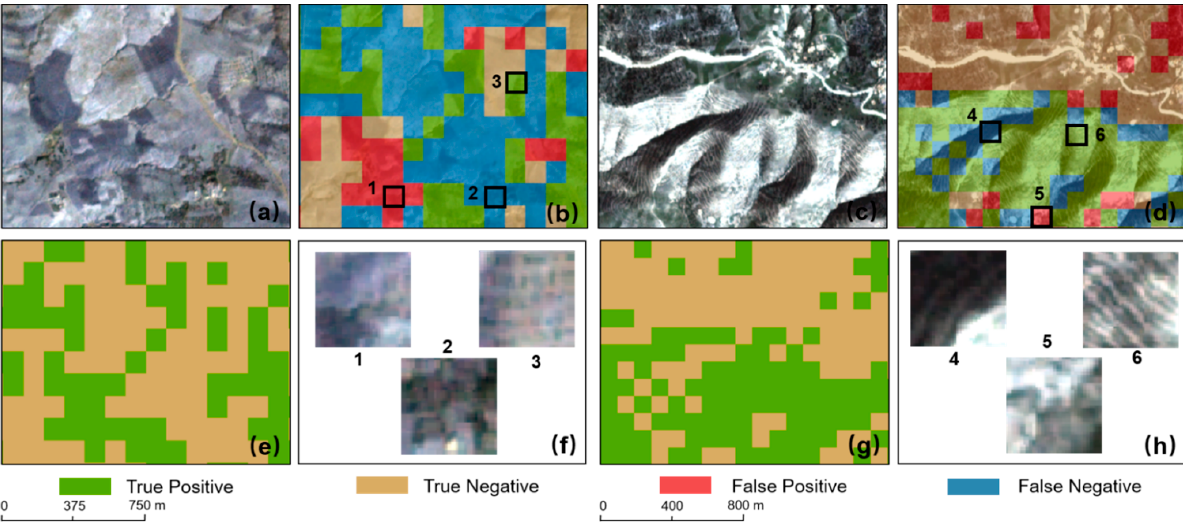
Figure 10. Olive mapping results using the grid sampling approach and Planet imagery. The legend only applies to ( b , d ). ( a ) RGB imagery in grid 5, semi-arid site 5; ( b ) classification map showing TP/TN/FP/FN in grid 5, semi-arid site 5; ( c ) RGB imagery in grid 4, sub-humid site 9; ( d ) classification map showing TP/TN/FP/FN in grid 4, sub-humid site 9; ( e ) classification map in grid 5, semi-arid site 5; ( f ) examples for false positive and false negative values in grid 5, semi-arid site 5; ( g ) classification map in grid 4, sub-humid site 9; ( h ) examples of false positive and false negative values in grid 4, sub-humid site